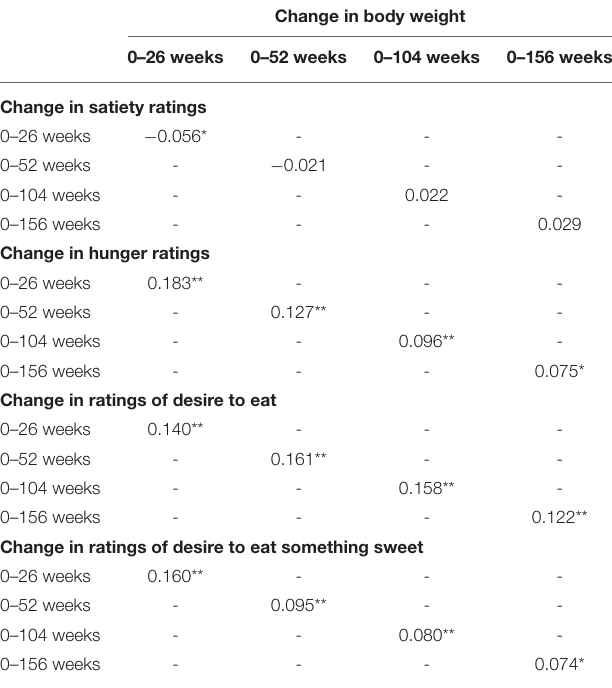
TABLE 2 | Spearman correlation coefficients of relationship between change in body weight and changes in appetite sensation ratings from baseline to 156